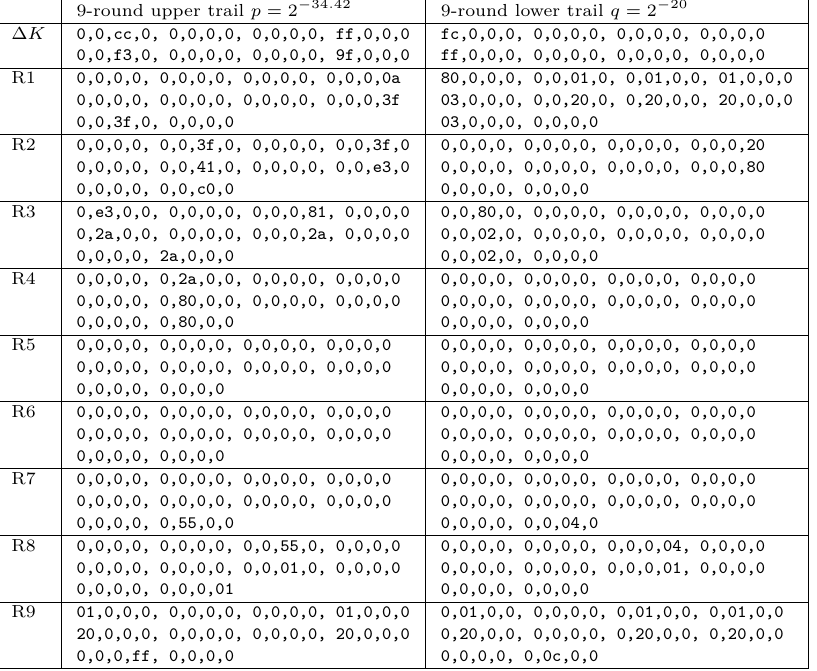
Table 4: Differential trails of SKINNY -128-256 where each non-zero cell is given in hexadecimal. The master tweakey difference is denoted by ∆ K . For each round of SKINNY , input/output differences of the S-box layer in each round, as well as the the round tweakey difference are